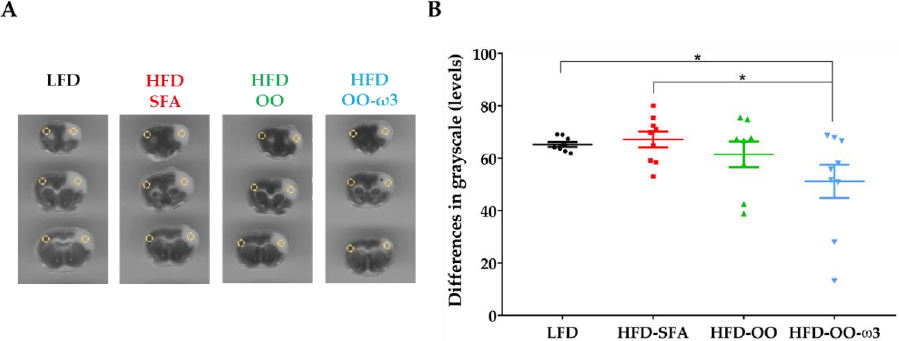
Figure 5. HFD-OO-ω3 diet improves infarct severity in mice subjected to transient focal cerebral ischemia. Groups: LFD (Black), HFD-SFA (Red), HFD-OO (Green), and HFD-OO-ω3 (Blue). ( A ) Representative grayscale images of TTC staining to determine infarct severity. Three coronal sections along the rostro-caudal axis are shown, as well as the ipsilateral and contralateral ROI probes used in the analysis (yellow circles). ( B ) HFD-OO-ω3 diet improved brain infarct severity compared to HFD-SFA and LFD. The results represent the mean ± SEM of 8 to 9 animals: * p ≤ 0.05 (ANOVA + Bonferroni post-hoc). Low-fat diet ( LFD ), high-fat diet rich in saturated fatty acids ( HFD-SFA ), high-fat diet rich in olive oil ( HFD-OO ), and high-fat diet rich in olive oil plus DHA and EPA ( HFD-OO-ω3 ) .